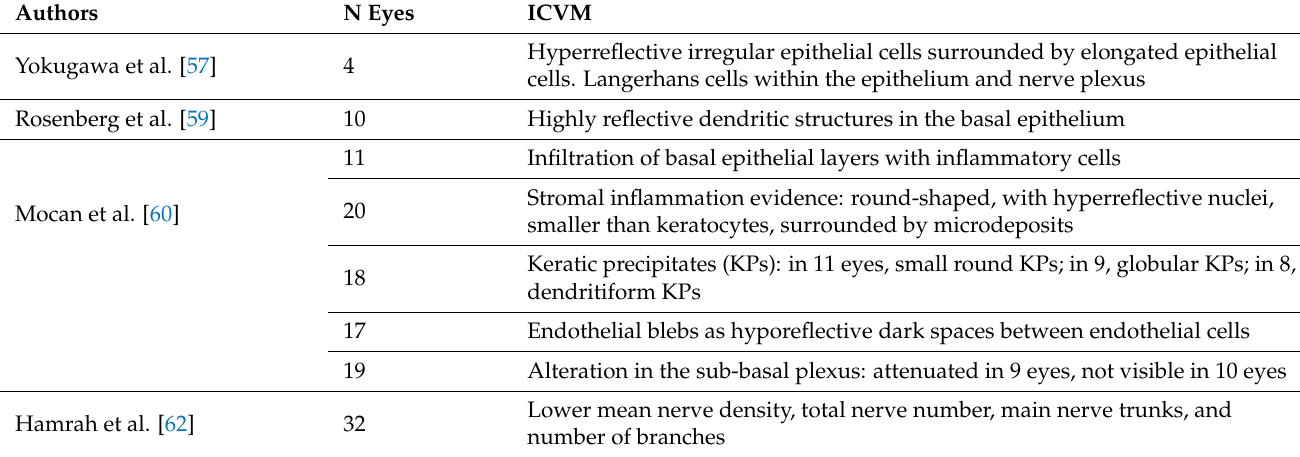
Table 2. Clinical characteristics of eyes in studies analyzing the cornea using in vivo confocal microscopy